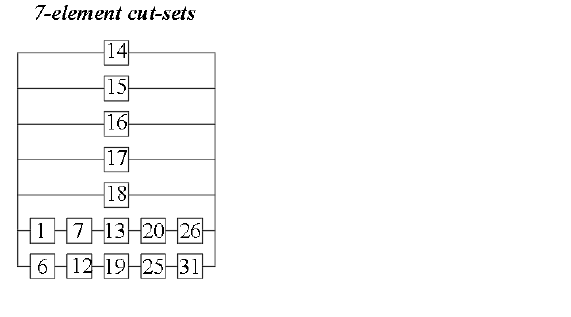
The 1st change of the static scheme: